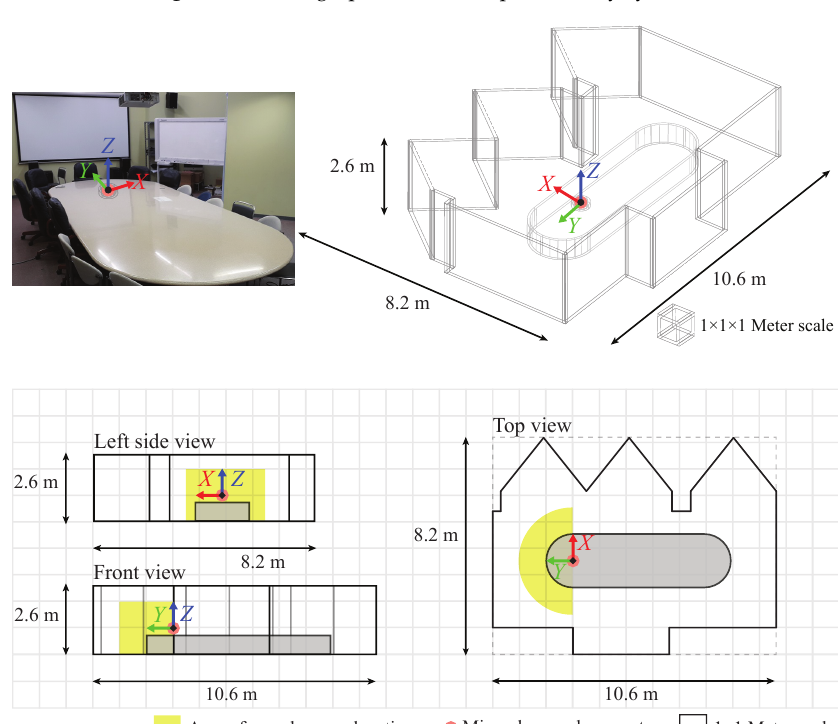
Figure 11. Photograph of the experimental environment, floor plan and the room